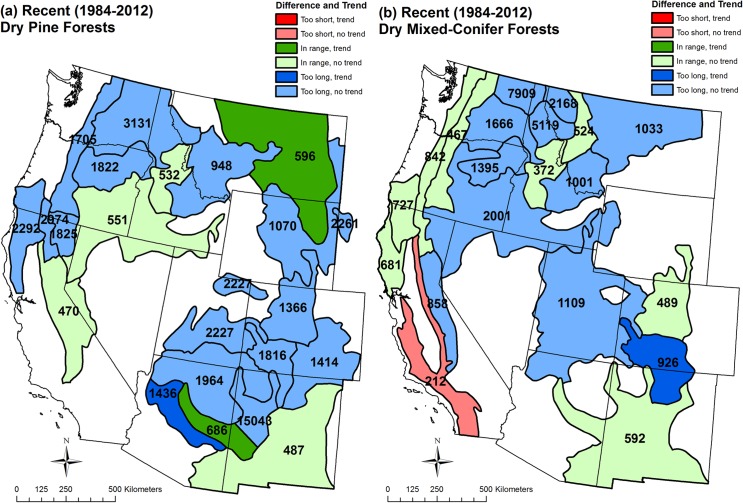
Differences between recent (A.D. 1984–2012) high-severity fire rotation and historical range of high-severity fire rotations, recent trends, and recent fire rotations for high-severity fire in (a) dry pine forests and (b) dry mixed-conifer forests by analysis region.High-severity fire rotation (years), from Tables 3 and 4, is printed over each region, and represents the expected time to burn, at high severity, an area equal to the region. Colors correspond with data in Table 3 for dry pine and Table 4 for dry mixed conifer forests. Differences are: (1) “In range,” if recent high-severity fire rotation was within the range of historical estimates, (2) “Too short,” if outside and shorter than historical estimates, and (3) “Too long,” if outside and longer than historical estimates. “Trend” indicates that a statistically significant upward trend in area burned at high severity was found in a region, and “No trend” indicates one was not found, with data shown in Tables 3 and 4. Regions that lacked a statistically significant upward trend in area burned at high severity (Tables 3, 4) have lighter shading. Several Bailey sections were merged or split to create the analysis regions.